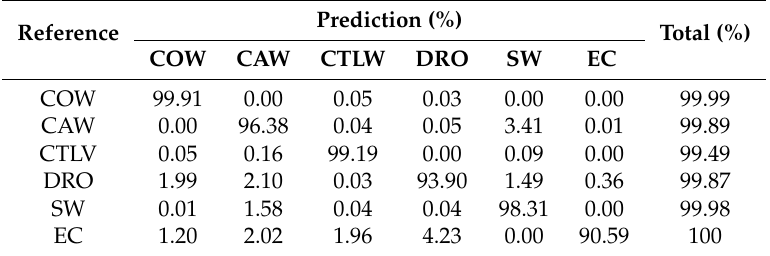
Table 4. Confusion matrix of partial classes in the unidirectional mode. Values denote the point proportion of the reference.